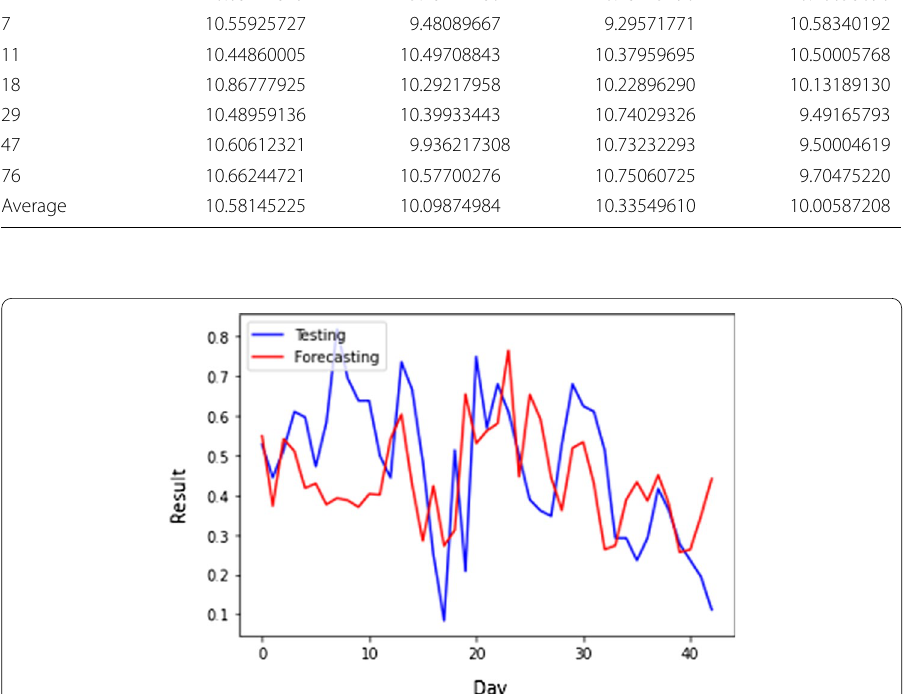
Fig. 9 The forecasting results of S-CNN scenario